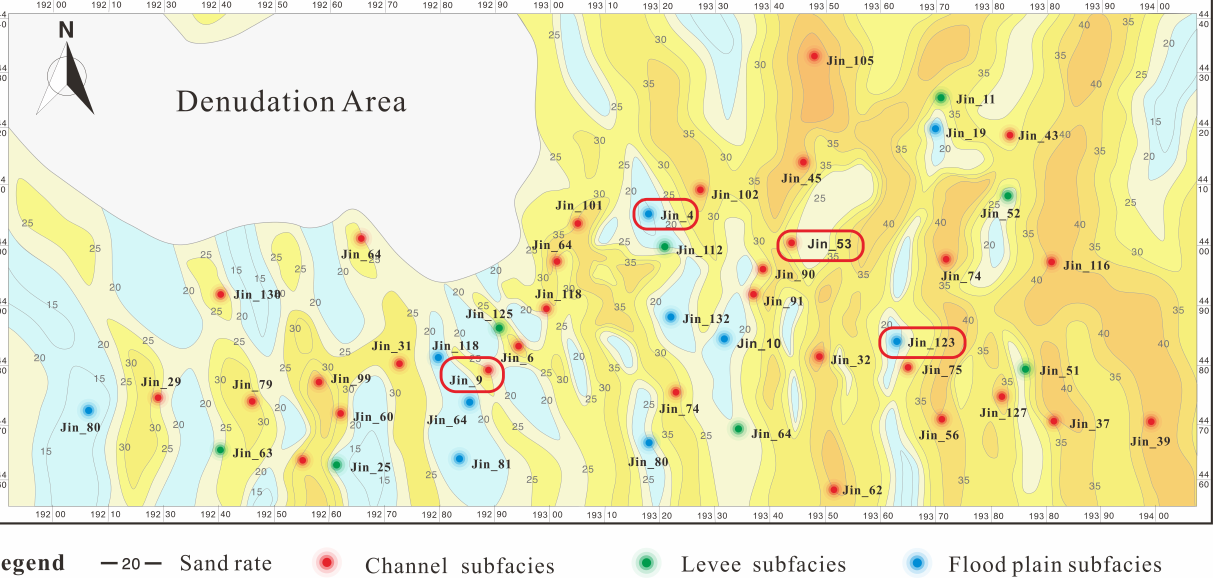
Figure 11. Borehole fluvial facies distribution map of the Hangjinqi gas field in the Ordos